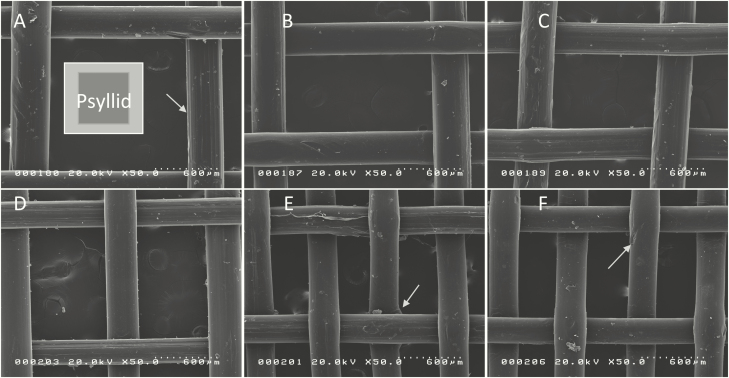
SEM image of the six screens: (A) PME066, (B) PME096, (C) PME108, (D) Polysack25, (E) PME1610, (F) Polysack40. Arrows point out small defects in screen manufacture. The square marked ‘psyllid’ is the largest and smallest measured dimensions out of 336 males and 337 females.